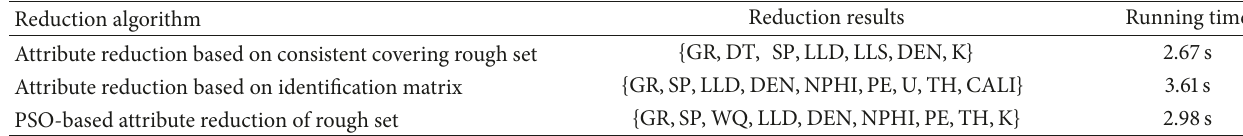
Table 6: Comparison of reduction results.